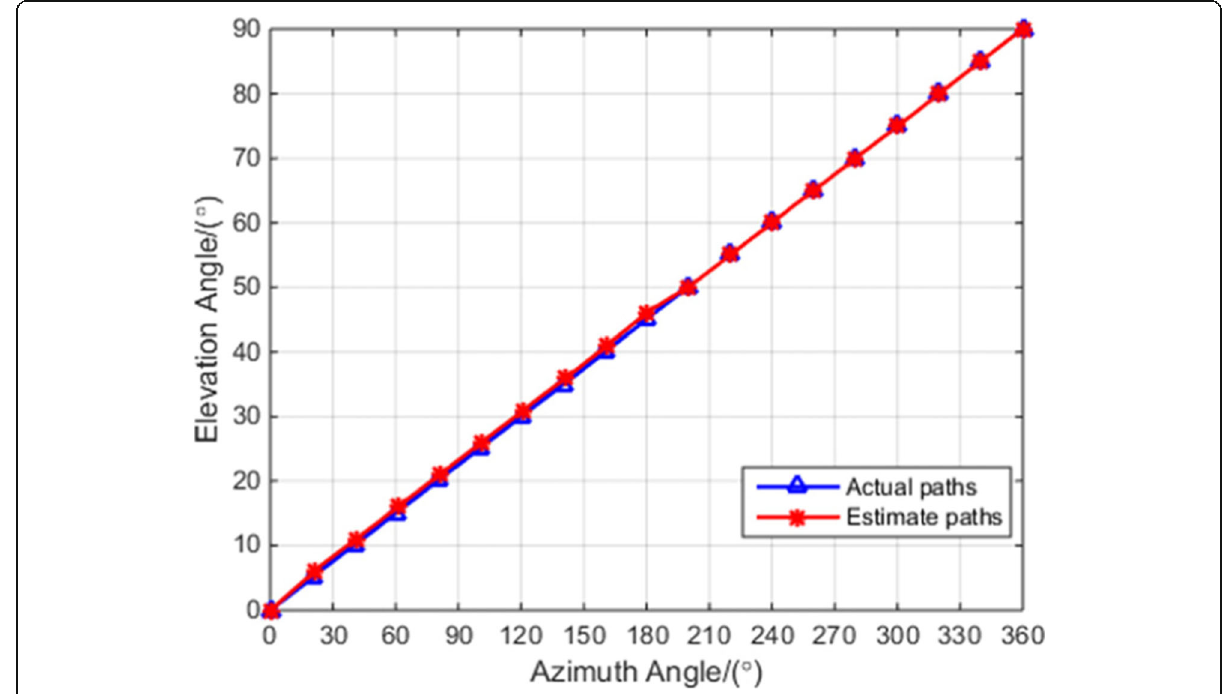
Fig. 19 Tracking performance in an ideal environment